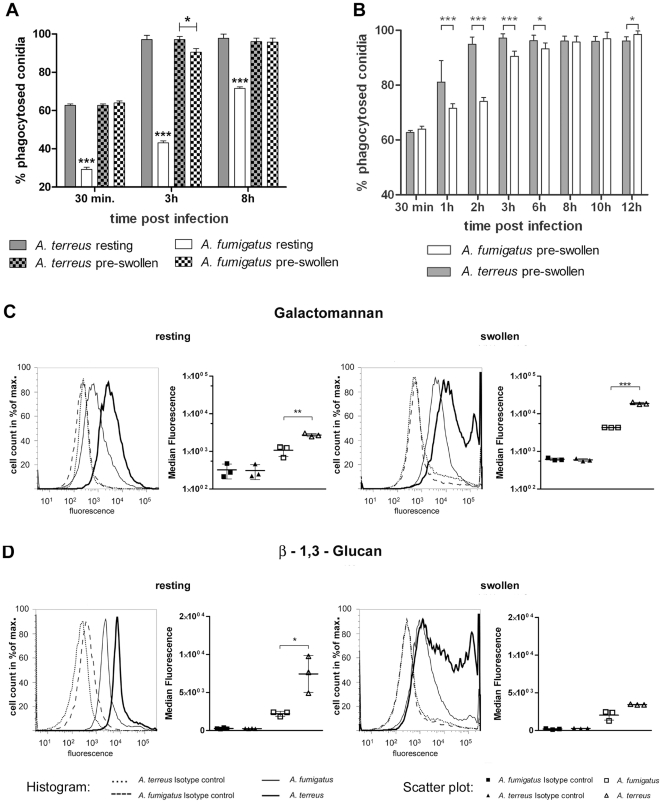
Phagocytosis rates and surface exposure of galactomannan and β-1,3-glucan on resting and swollen A. terreus and A. fumigatus conidia.
Results are shown for A. terreus SBUG844 and A. fumigatus CBS144.89. (A, B) Phagocytosis of conidia by alveolar macrophages (MH-S cell line). Phagocytosis rates are shown as mean+SD from three independent experiments. Statistical analysis was performed using 1-way ANOVA. * P<0.05, ** P<0.01, *** P<0.001. (A) Phagocytosis of resting and pre-swollen conidia after 0.5, 3 and 8 h of co-incubation. (B) Phagocytosis of pre-swollen conidia over 12 h. (C) FACS analysis of galactomannan and (D) β-1,3-glucan exposure. Histograms (one representative result from three independent experiments is shown) and scatter plots of median fluorescence intensity are shown (mean ± SD, three independent experiments). Statistical analysis was performed using paired t-test. * P<0.05; ** P<0.01; *** P<0.001. Dashed and dotted lines in the histogram show the respective isotype controls while the full lines represent specific fluorescence for A. fumigatus (thin) and A. terreus (thick).